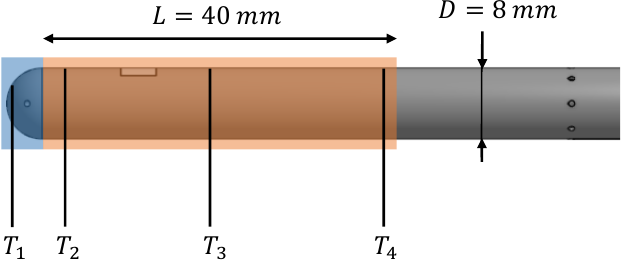
length, the value T test is defined as the mean temperature averaged with these three values. The comparison between T analytical and T test is given in Table 4. The formulas for the calculation of the error ∆ T and the relative error δ T with respect to T test are given in Equations (11) and (12). The relative error is computed with respect to the temperature difference to set T ∞ as the reference. The comparison between T analytical and T test is also represented in Figure 14, where the function T analytical = T test is represented by a line in black in order to show the agreement between the test results and the model.